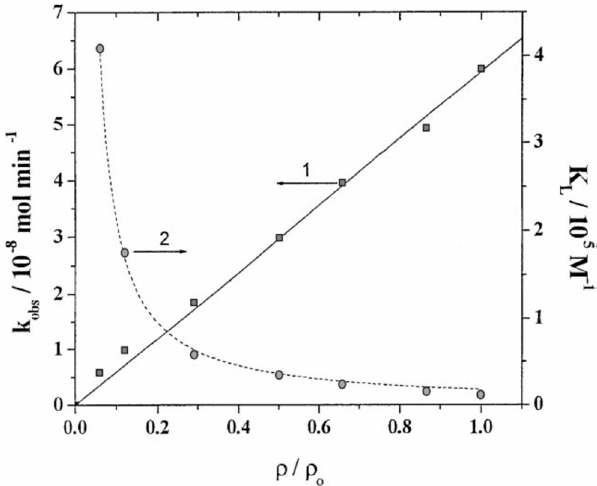
Figure 7. Dependence of the apparent constants k and K L on light intensity for the photodegradation of phenol over TiO 2 . Reproduced with permission from Emeline et al. [32]. Copyright 2000 by Elsevier B.V. (License No. 4452260016035).